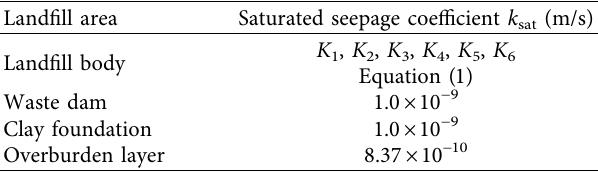
Table 1: Seepage characteristics of the local material in